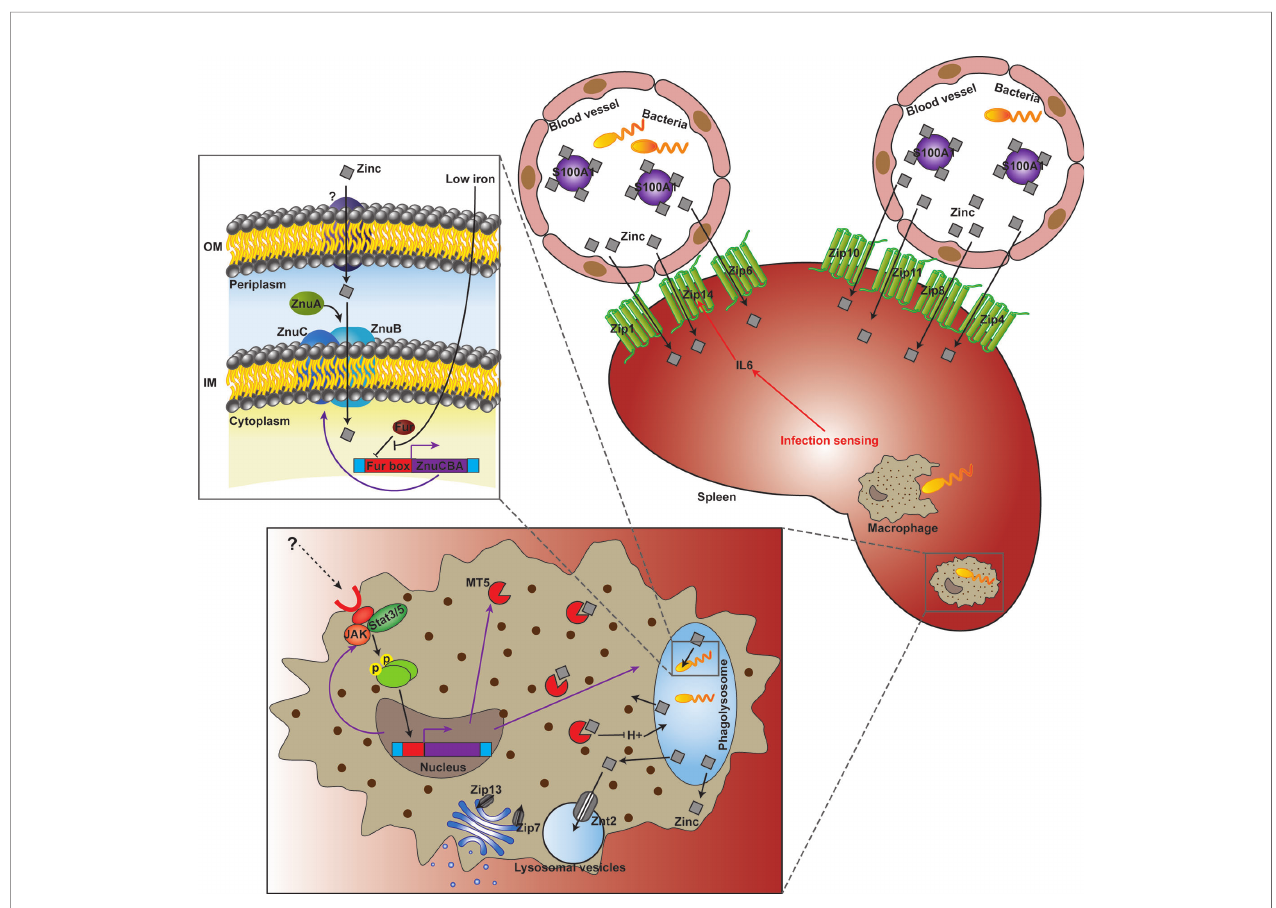
FIGURE 7 | Working model of the struggle for Zinc (Zn) between Epinephelus coioides and Pseudomonas